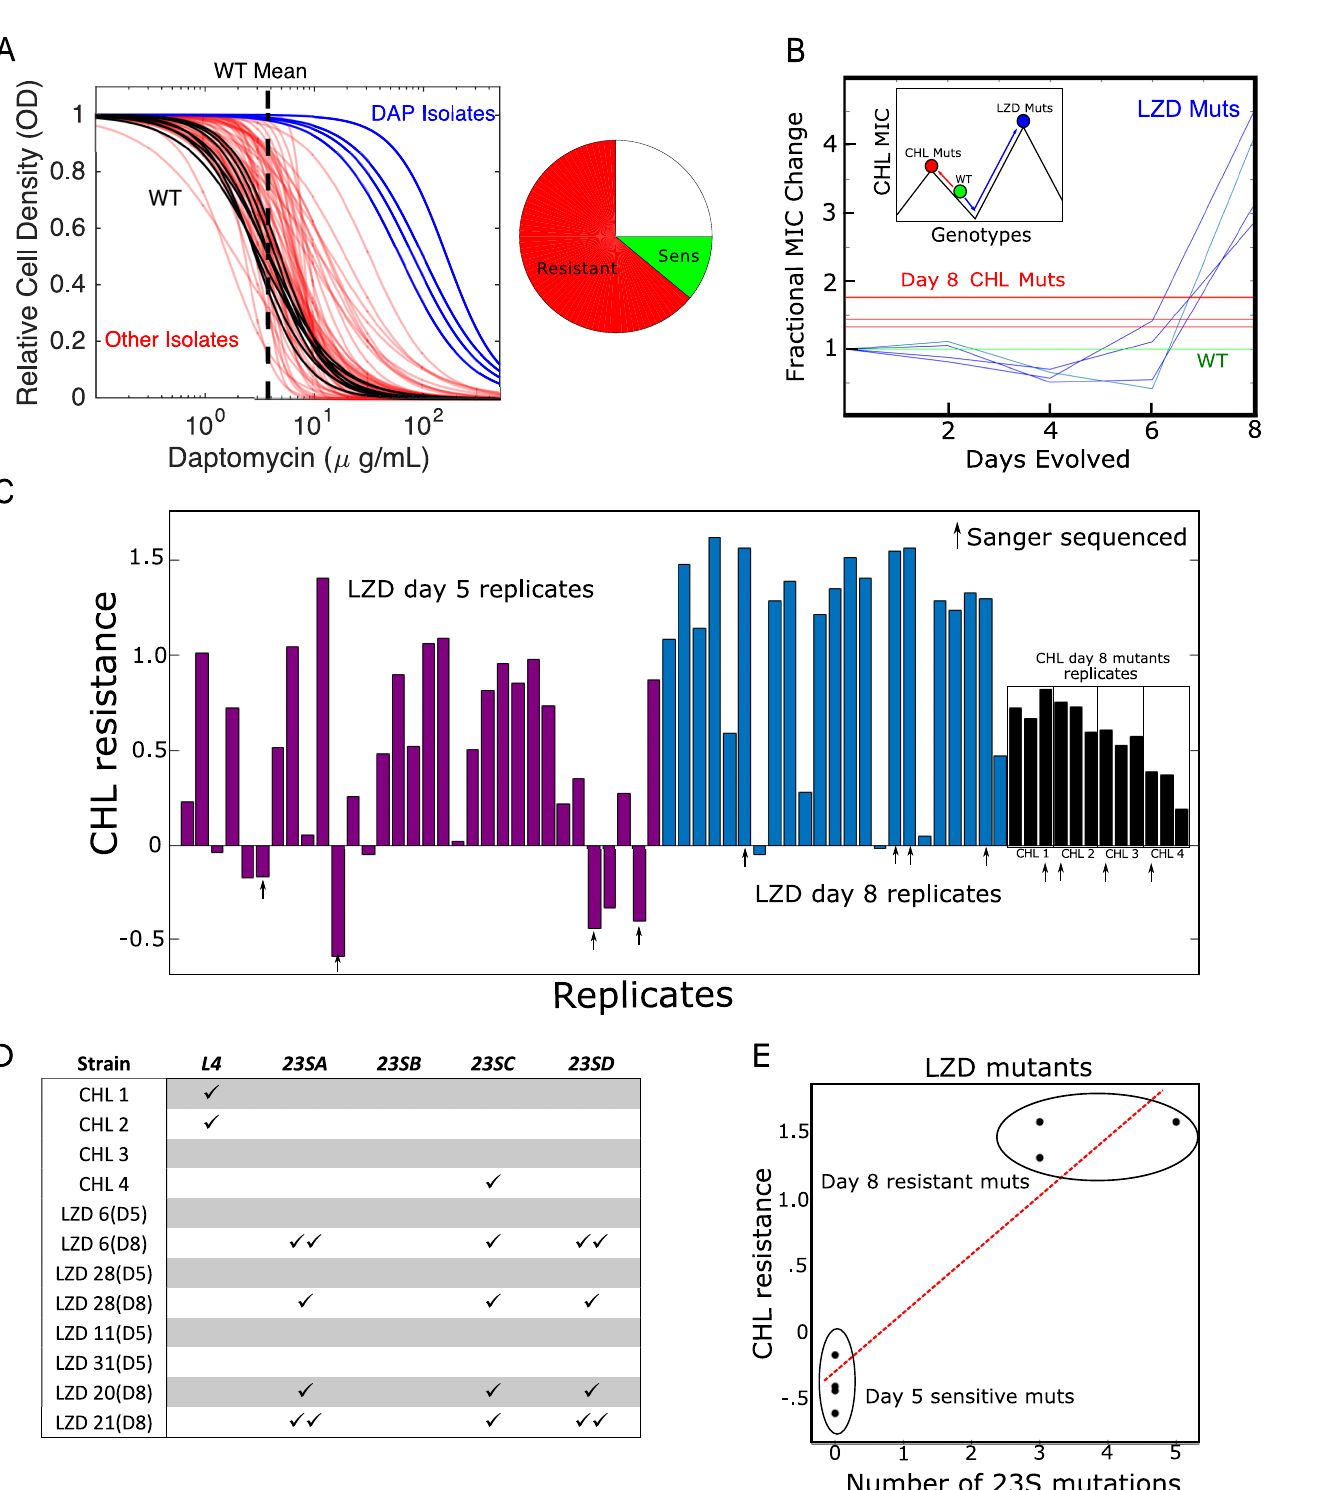
Fig 3. Collateral effects can lead to frequent or high-level resistance to nonselecting drugs. (A) Estimated dose-response curves (fit to Hill-like function) for all mutants tested against DAP. Strains evolved to DAP (blue) and all other drugs (red) frequently exhibit increased resistance to DAP relative to WT (black, individual replicates; dotted black line, mean IC 50 ). Right inset: Approximately 64% of all drug-evolved mutants exhibit increased DAP resistance, while only 11% exhibit collateral sensitivity. (B) Fractional change in CHL IC 50 for mutants evolved to LZD (blue). The width of the green line represents the confidence interval ( ± 3 standard errors of